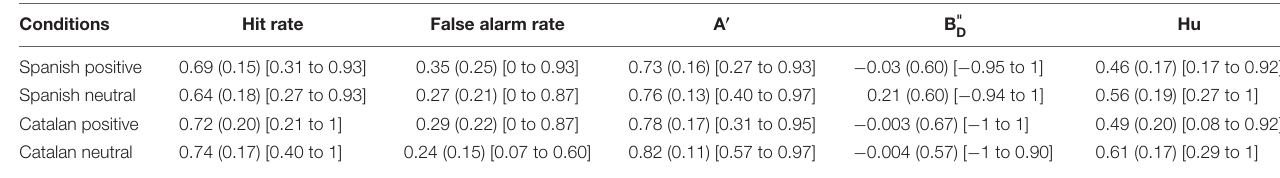
TABLE 4 | Mean, standard deviation (in parentheses), minimum and maximum values (in square brackets) of the dependent variables across experimental conditions in Experiment 3.